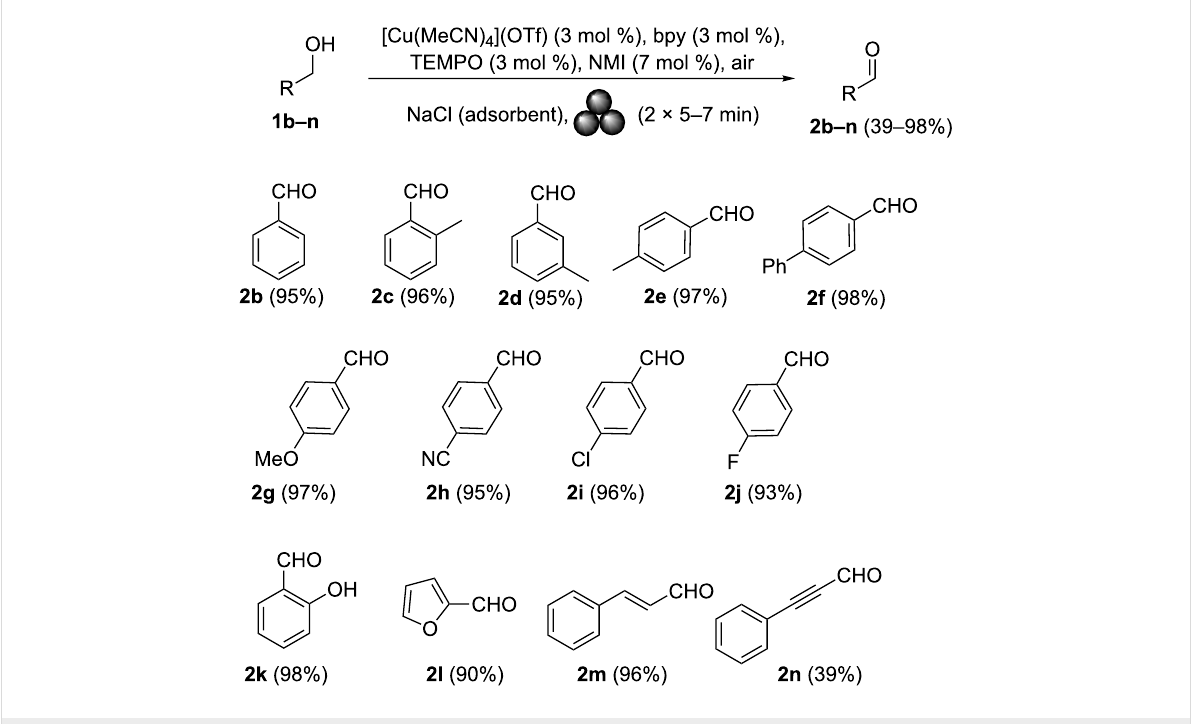
Scheme 3: Scope of primary alcohols in oxidation under ambient air.